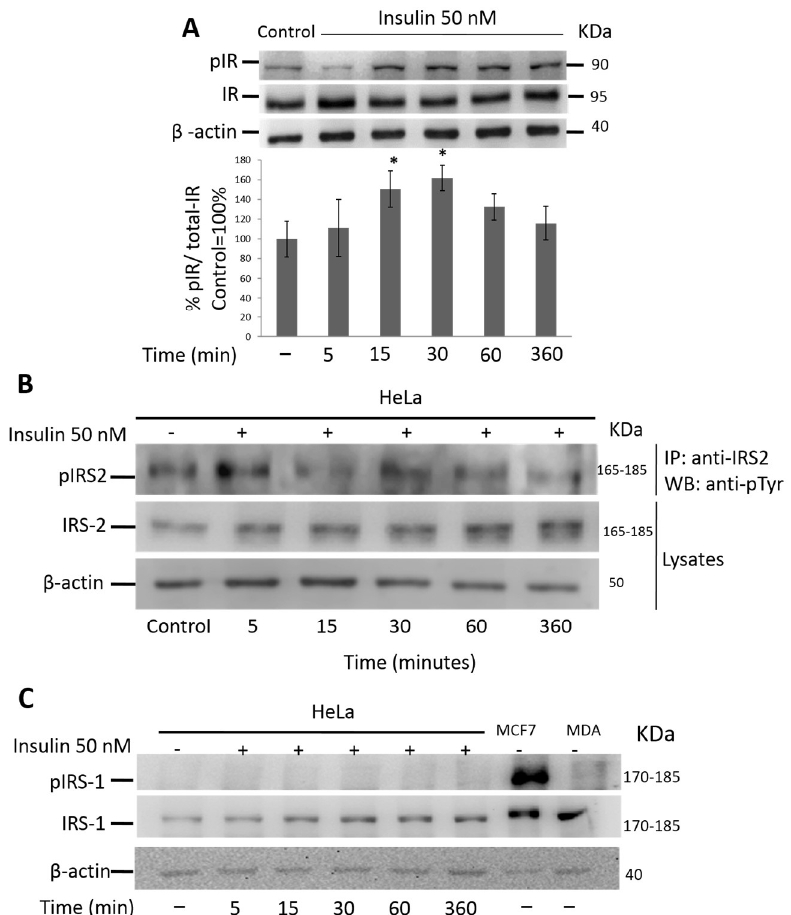
Figure 3. Insulin induces the phosphorylation of IR and IRS2 but not IRS1 in HeLa cells. Protein extracts from HeLa cells stimulated with 50 nM insulin were used to evaluate IR, IRS1, phospho-IRS1, IRS2, and phospho IRS2 by WB. ( A ) Densitometric analysis of phospho-IR and actin protein levels. The first bar is the control group without treatment. One-way ANOVA was performed, followed by the Tukey post hoc test to compare the treated groups against the control group (100%). * p < 0.05. All experiments have been performed in three independent experiments in triplicate, and experimental data were expressed as mean ± standard deviation (SD). ( B ) Cells were lysed with RIPA. IRS2 protein was immunoprecipitated, and immunoblot analyses were performed to identify the indicated proteins from IP or cell lysates. ( C ) HeLa cells were stimulated in the absence (control) or presence of 50 nM insulin for the indicated time. MCF7 and MDA-MB-231 cells were used as positive and negative controls, respectively. IRS1 and phospho-IRS1 protein levels were detected by immunoblot analysis. ϐ -Actin was used as a control for protein degradation.